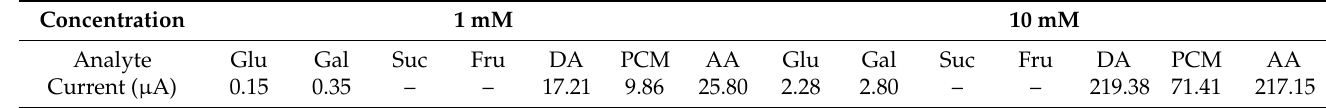
Table 3. Selectivity test on the PdNS-modified f-CNT/SPCE of glucose in the presence of some coexisting organic